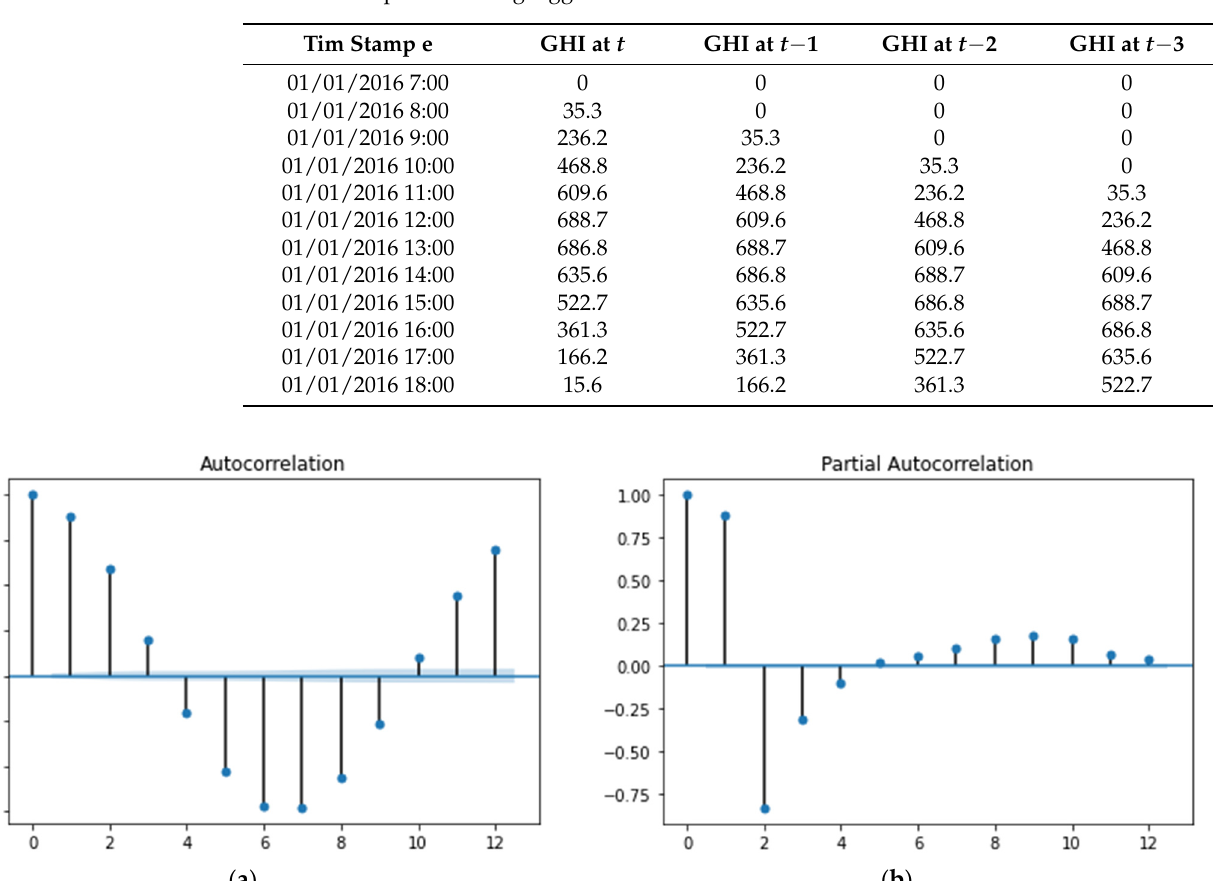
Table 5. Example of creating lagged features of GHI.